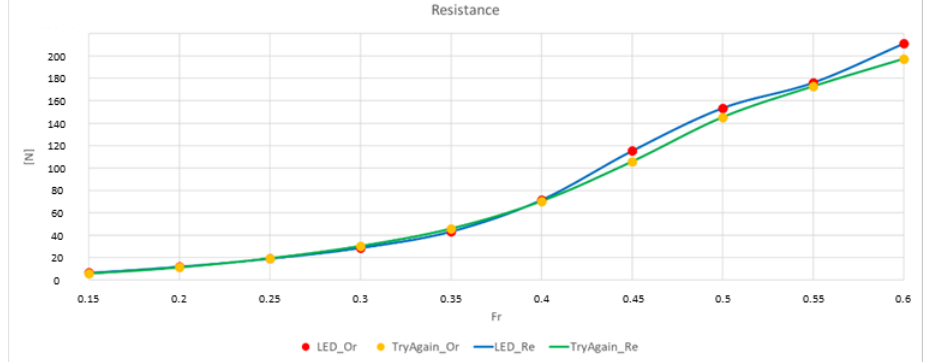
Figure 18. Resistance curves of the original and rebuild hulls.